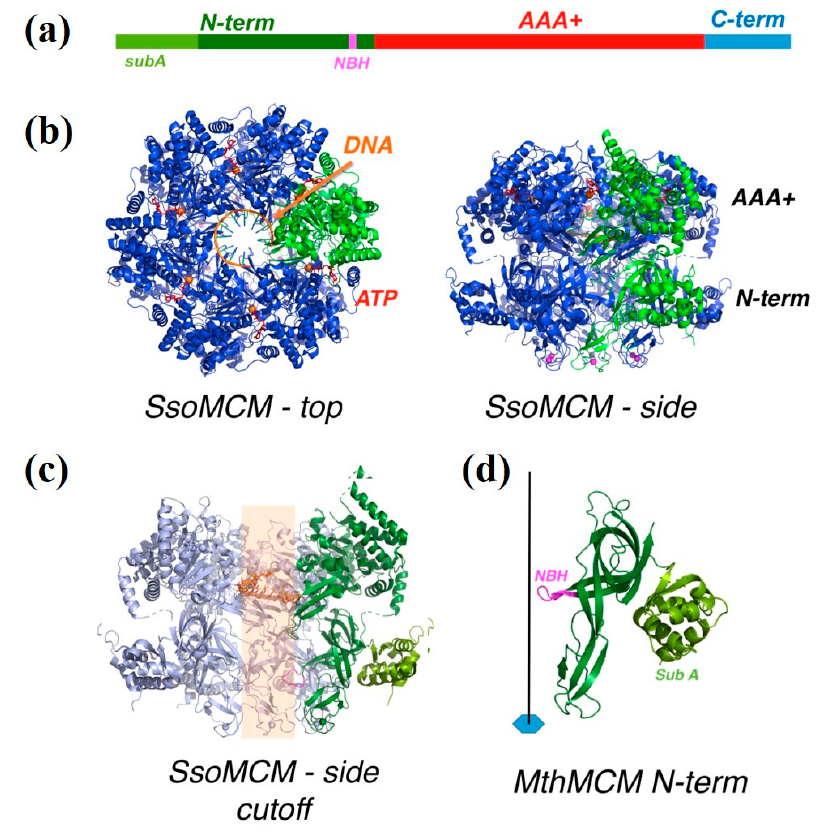
Figure 1. ( a ) A schematic diagram of the architecture of a minichromosome maintenance (MCM) monomer, showing the N-terminal domain in green, the AAA+ domain in red and the C-terminal domain in blue. Within the N-terminal domain, subdomain A and the N-terminal β -hairpin (NBH) are highlighted in light green and magenta, respectively. The C-terminal domain is not visible in the structure. ( b ) The three-dimensional structure of an archaeal MCM hexamer ( Sulfolobus. solfataricus MCM (SsoMCM), PDB ID: 6MII [13]) bound to DNA, viewed from the top and from the side: one monomer is highlighted in green; the DNA is shown in orange; the ATP bound at the interface between monomers is in red. ( c ) A side view of the SsoMCM hexamer, with the two front monomers removed, so as to see the interior of the channel; a short stretch of DNA is seen bound to the AAA+ domain, but is expected to thread the whole channel (shown by the semitransparent orange stripe); on the green monomer, subdomain A is highlighted in lighter green, and the N-terminal β -hairpin, projecting into the channel, in magenta. ( d ) A close-up of the N-terminal domain from Methanothermobacter thermoautotrophicus MCM (PDB ID: 1LTL [14]), with the same color code as panel A and C; the position of the hexameric axis (which coincides with the central channel) is